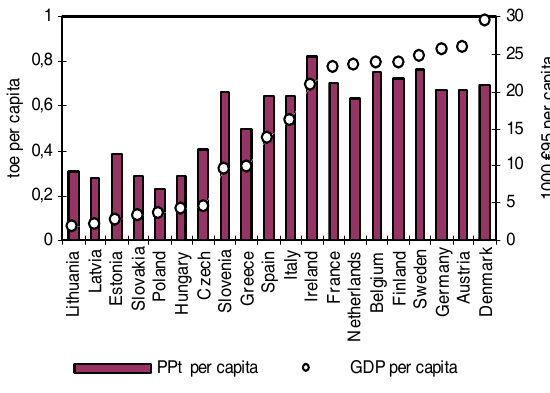
Fig 2 . Changes of relative final consumption of petroleum products per capita in EU countries